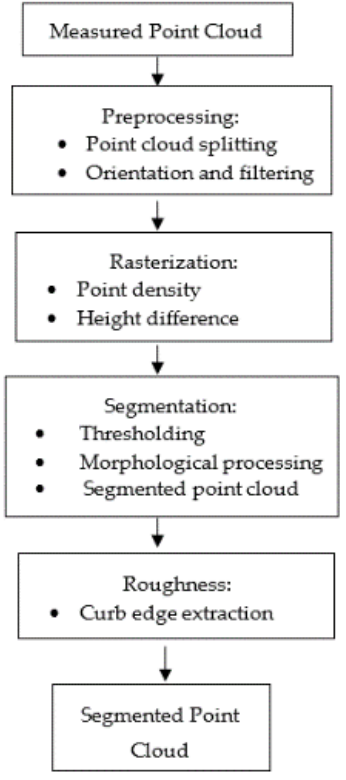
Figure 1. Flow chart of the proposed method.